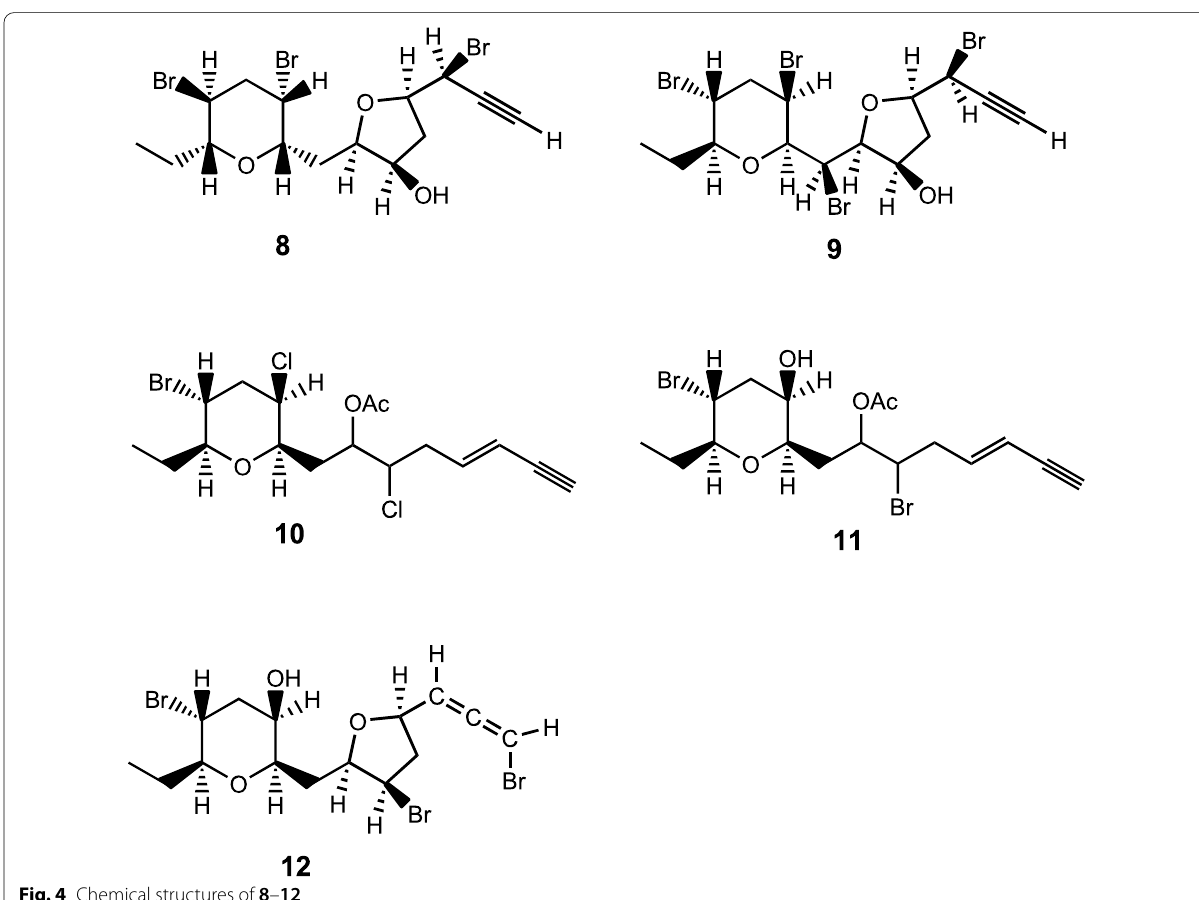
Fig. 4 Chemical structures of 8 –